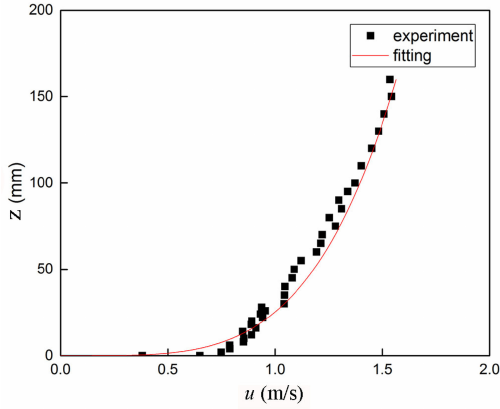
Figure 2. Experimental wind speed and fitting result.